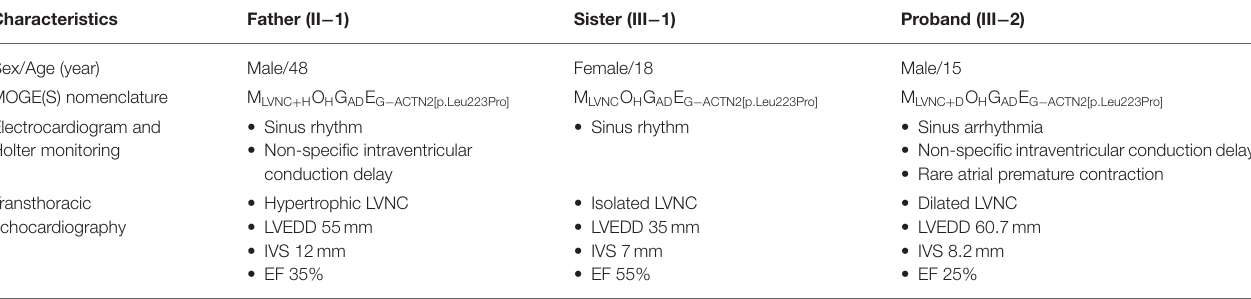
TABLE 1 | Clinical characteristics of individuals harboring novel ACTN2 variant diagnosed as left ventricular non-compaction.